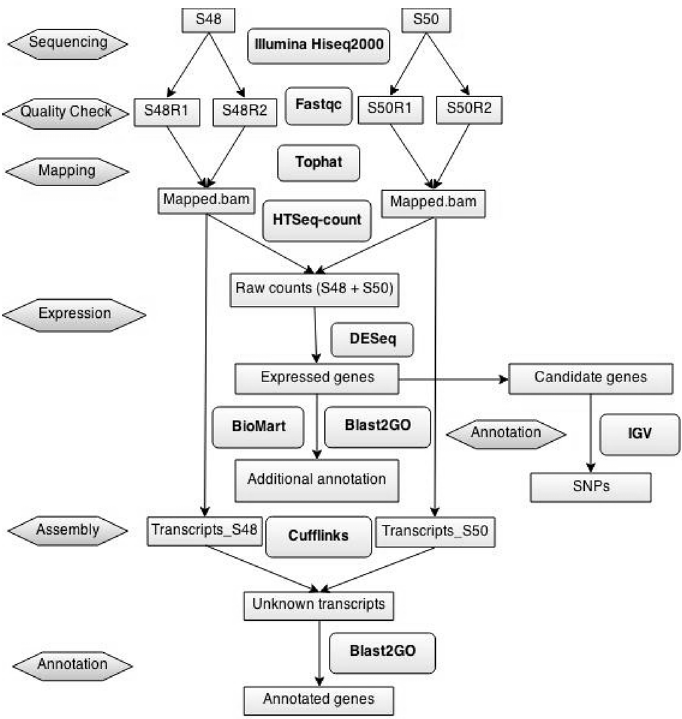
Fig. 1. RNA-Seq pipeline. Flowchart illustrates the bioinformatics pipeline used to analyse the RNA-Seq data. Arrows indicate data flow; analysis steps are marked by hexagons; rectangles indicate output data and rounded rectangles indicate tools and